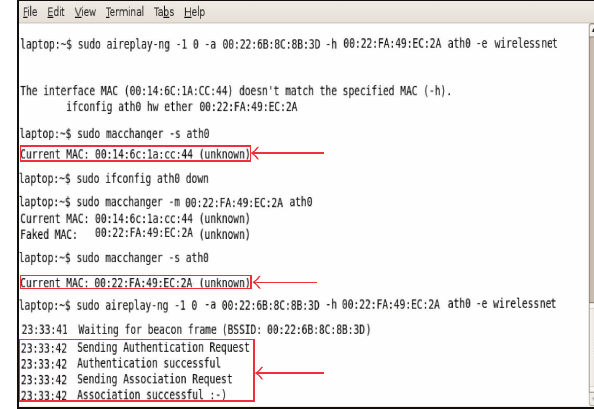
Figure 7: MAC address filtering attack.